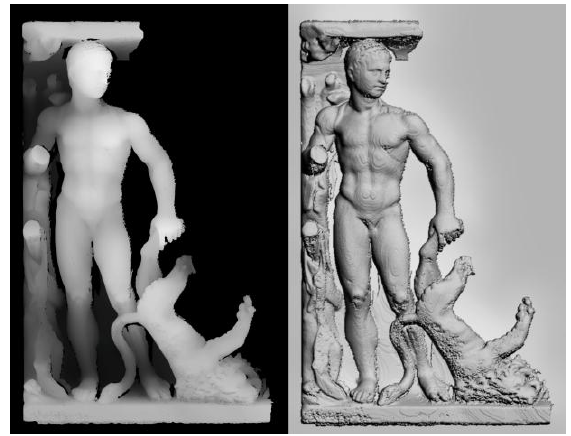
Figure 9. Height map and 3d model of a part of the